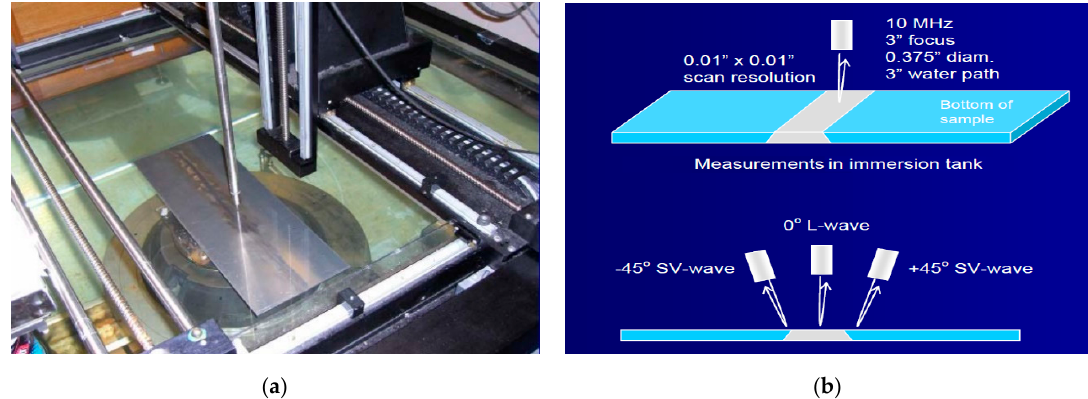
Figure 7. Inspection of FSW panels with wormhole defects ( a ) Experimental setup, and ( b ) schematic configuration for the ultrasonic inspection. [65].